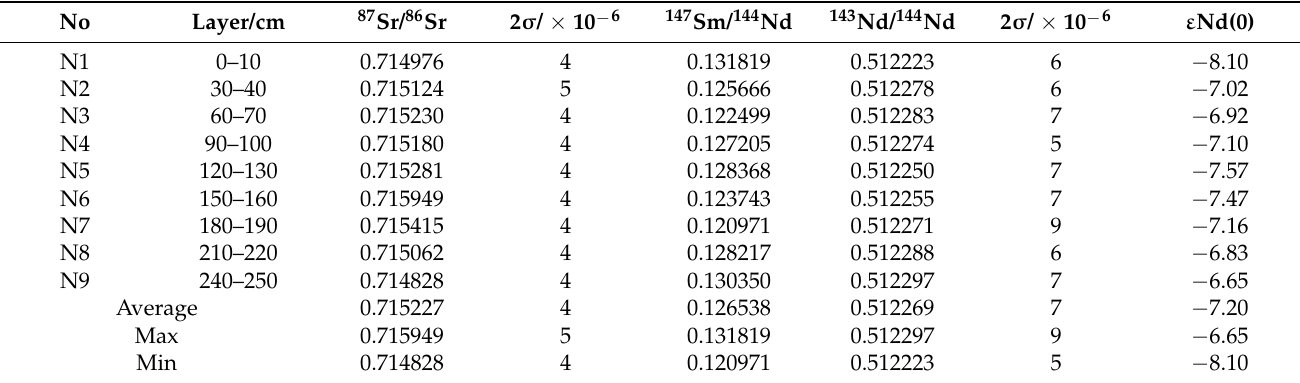
Table 2. Sr-Nd isotope values of